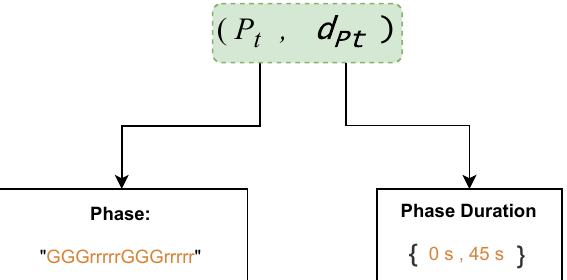
Figure 4. Example of the agent’s action that is applied to the traffic